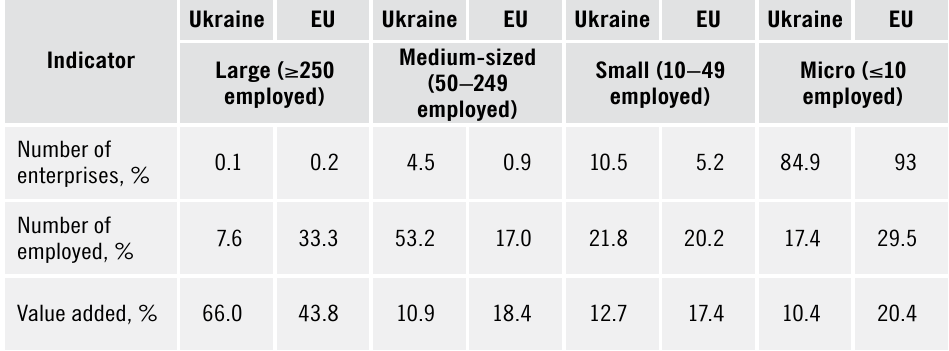
Table 3. Analysis of large, medium-sized, small, and micro enterprises for the EU and Ukraine in